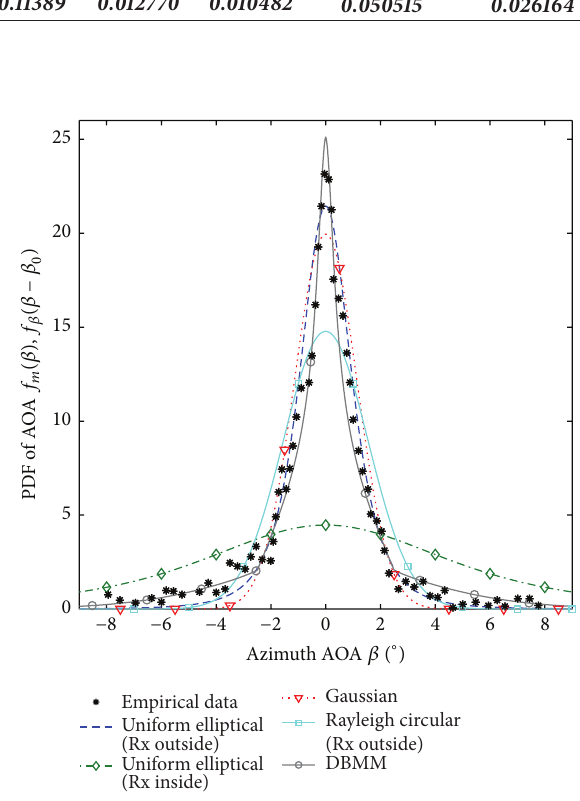
Figure 5: Fitting for various geometric models to the empirical data in Pedersen et al. [33, Figure 1